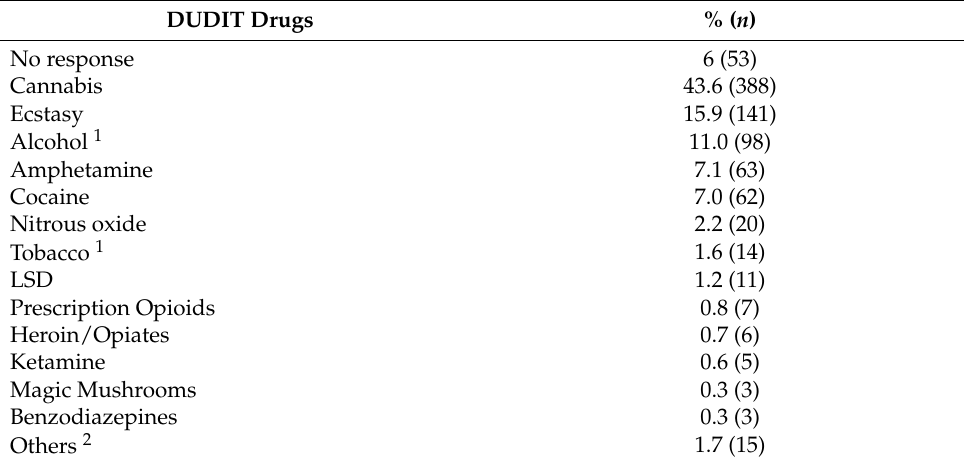
Table 8. Main drugs reported on the DUDIT